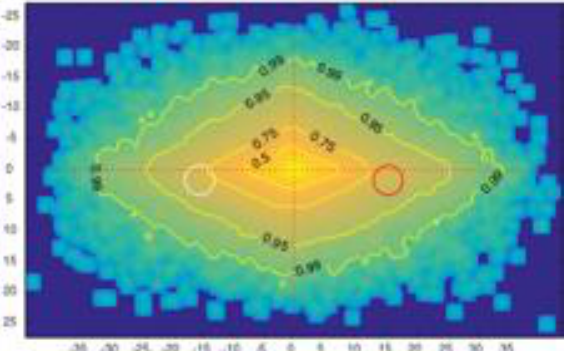
Figure 5. Probability density distribution of fixations during monocular (left-eye patched) free exploration of natural images in a large visual field. Distance from center is in visual degrees, and yellow contours enclose the corresponding probability mass. Red circle indicates the location of human blind spot, and the white circle indicates the corresponding location in the nasal visual